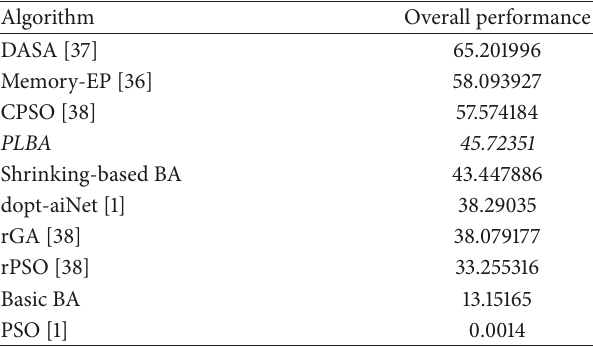
Table 3: Summary of the overall performance of the algorithms employed in the